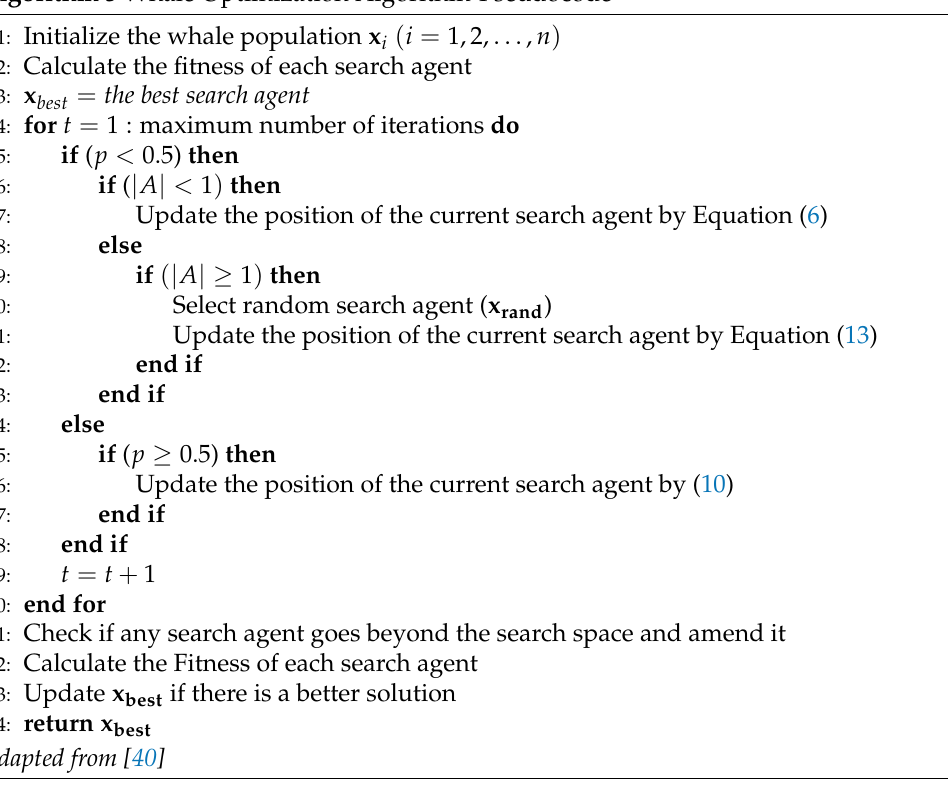
Algorithm 3 Whale Optimization